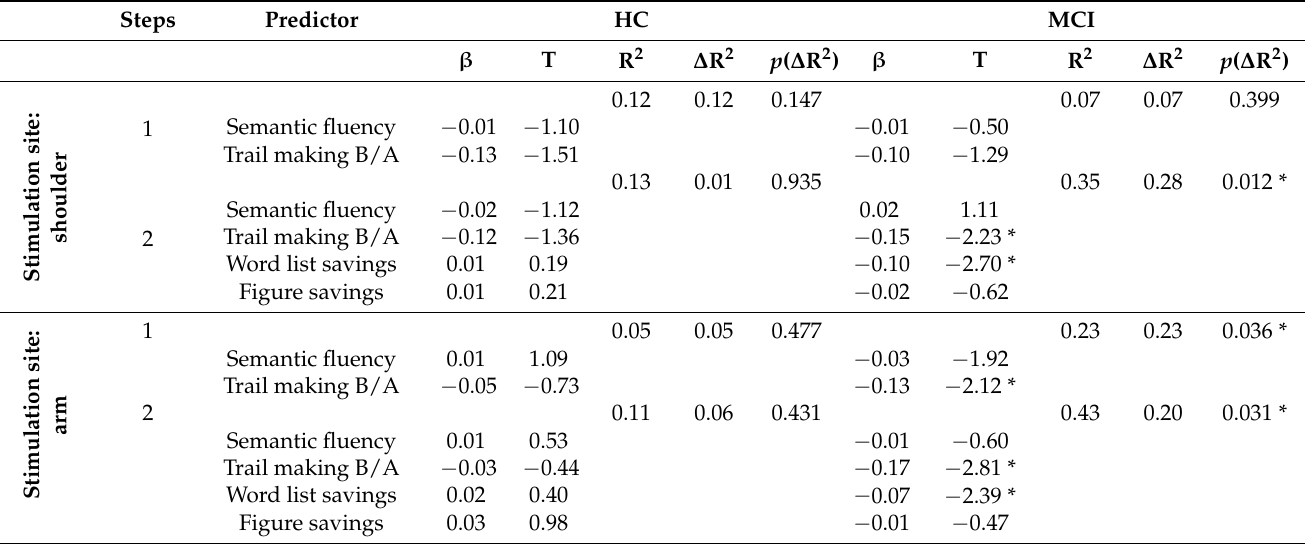
Table 3. Hierarchical regression analysis for executive and memory functions predicting the onset of pain perception (intercept). Findings are given separately for the two stimulation sites and the two subject groups. Steps